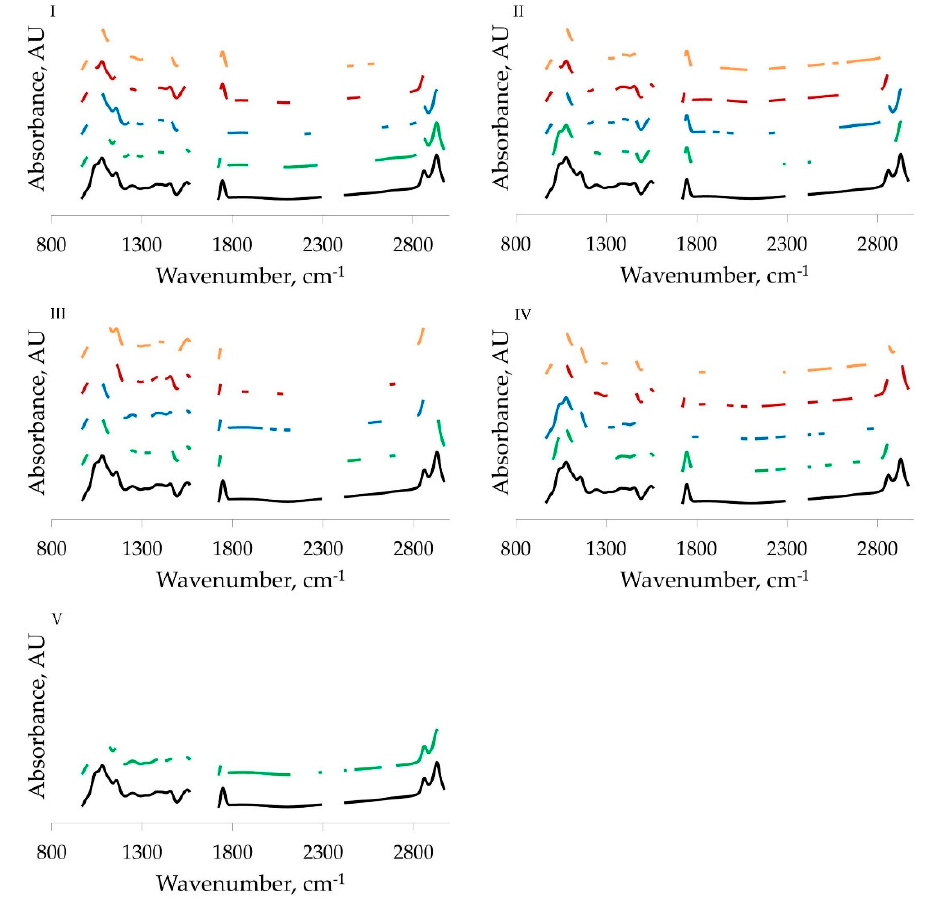
Figure 1. Spectral regions selected using backward interval partial least squares analysis. ( I ) Ca, ( II ) P, ( III ) K, ( IV ) Mg, ( V ) Na. (Black) full spectrum (mean); (green) total mineral (mg / 100 mL); (blue) micellar mineral (mg / 100 mL); (red) di ff usible mineral (mg / 100 mL); (orange) ratio between micellar and di ff usible fractions ( w / w ). Absorbance is given in arbitrary units (AU).